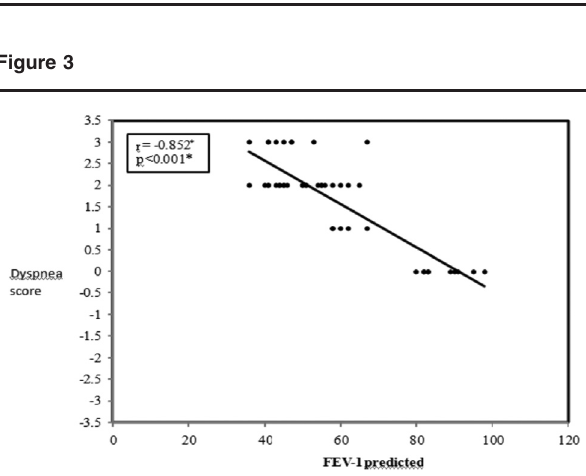
Correlation between FEV-1 predicted and dyspnea score.